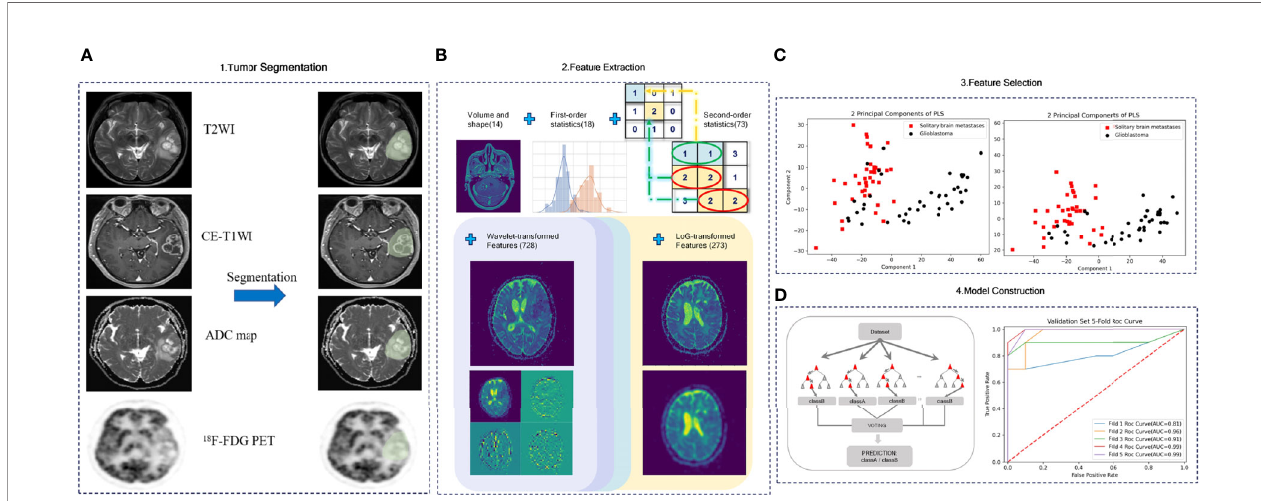
FIGURE 2 | Radiomics worklist. (A) Part 1 includes image acquisition, registration, and segmentation. Signal intensity normalization is conducted for CE-T1WI and T2WI. (B) Part 2 includes the extraction of radiomics features. (C) Part 3 includes feature selection. (D) Part 4 includes model